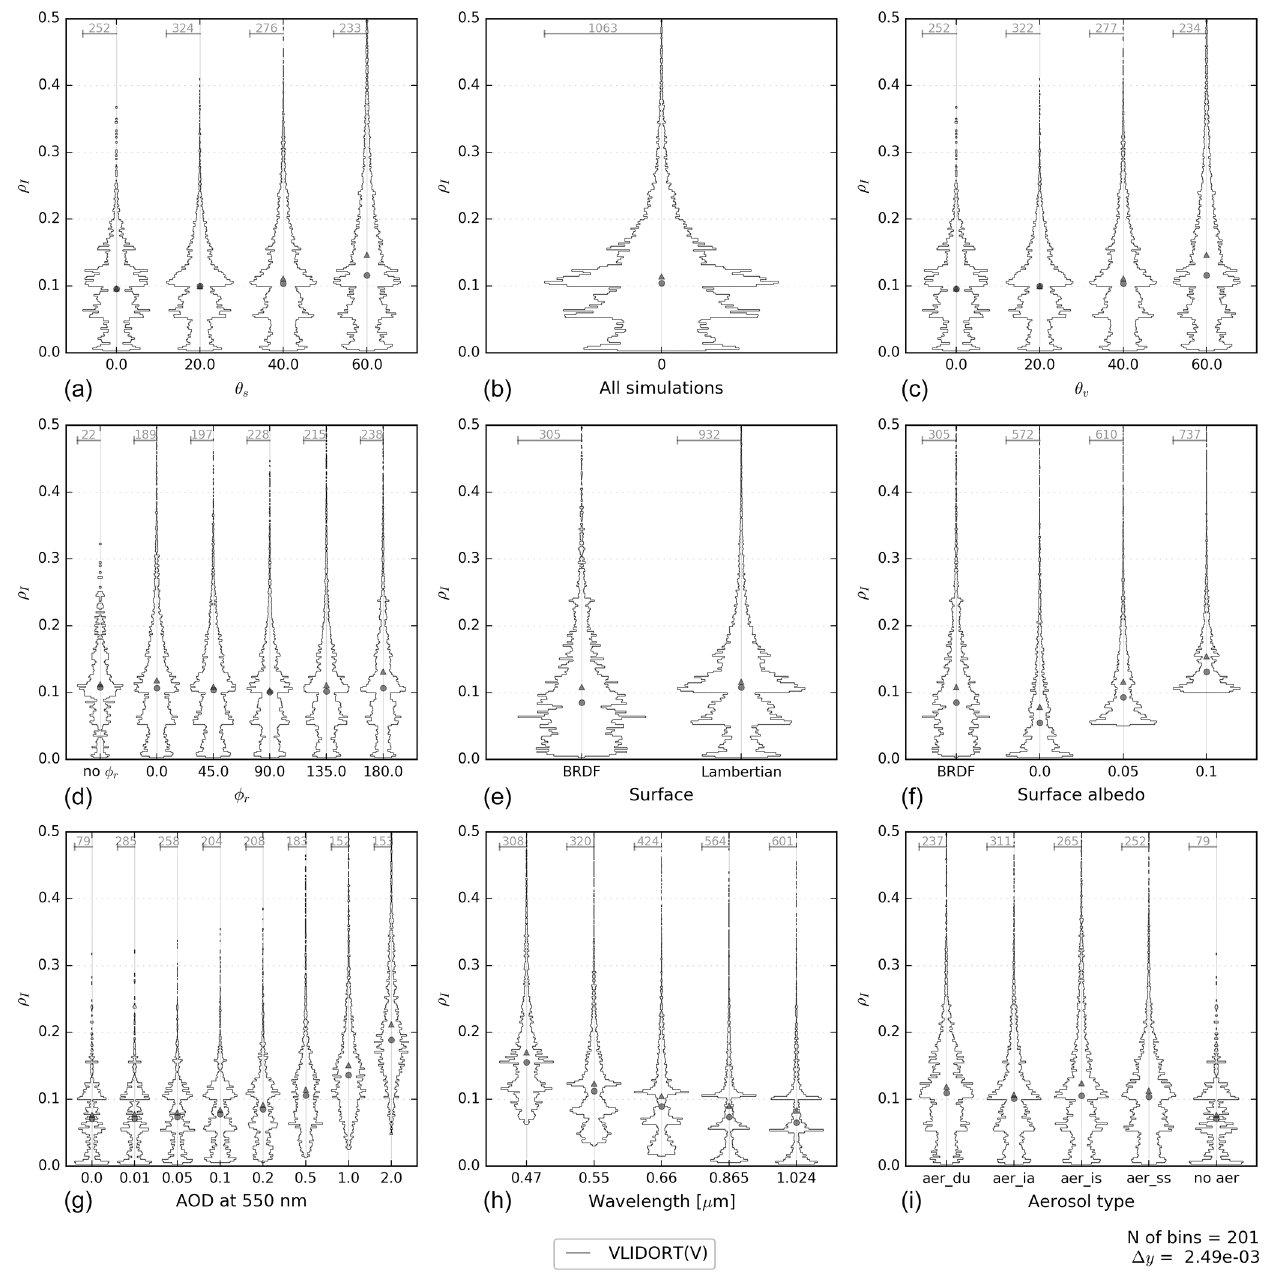
Figure 3. Histograms of the computed reflectances for the VLIDORT model. Panel (b) is a histogram of all considered cases, while the other panels classify the cases according to the value of θ s (a) , θ v (c) , φ r = φ v − φ s ( d , “no φ r ” corresponds to the cases where θ s = θ v = 0 . 0), and surface type – BRDF or Lambertian (e) , surface albedo value (f) , 550nm aerosol optical depth (g) , wavelength (in µm, h ), and aerosol type (“no aer” corresponds to AOD = 0, i ). The width of the classes is indicated at the bottom right ( (cid:49)y = 2 . 49 × 10 − 3 ), and the maximum number of cases in a class is provided for each histogram. The histograms are presented as “violin plots” with a rotated density plot on each side. Mean (triangles) and median (circles) values are indicated. Note that the scale used on the x axis is different for each violin